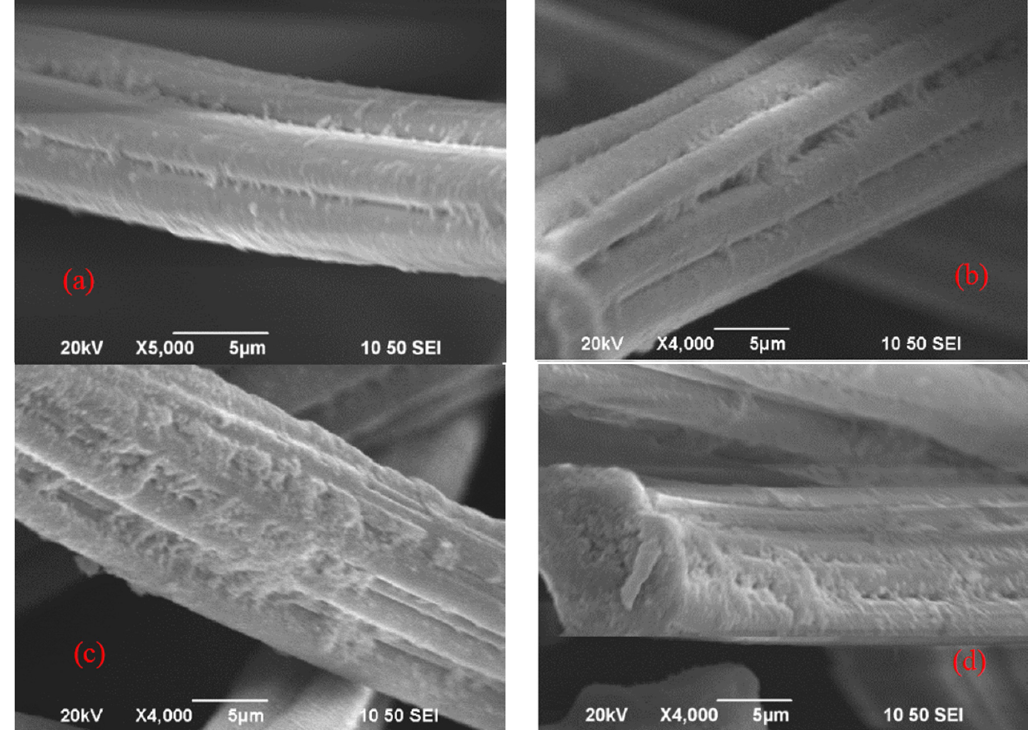
Figure 6. SEM micrographs illustrate the surface morphology of rayon flock leather after TMS plasma treatment with different amounts of TMS: ( a ) 0.1 mL, ( b ) 0.15 mL, ( c ) 0.2 mL, ( d ) 0.25 mL (treatment parameters: treatment time = 30 s; flow rate of helium = 12.5 LPM; jet distance = 10 mm; discharge power = 50 W). Table 3. Effect of amount of TMS on contact angle (treatment parameters: treatment time = 30 s; flow